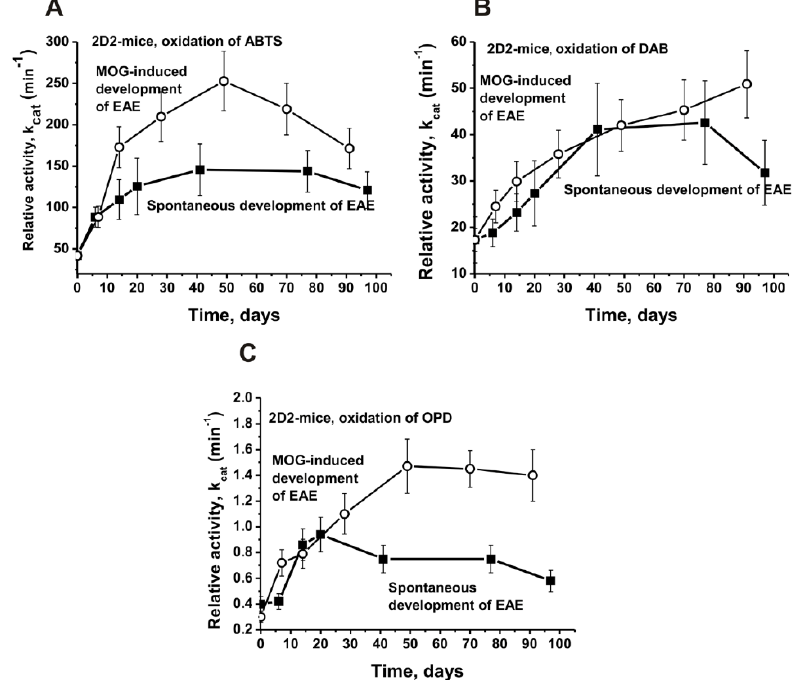
Figure 4. Average changes over time in the relative activity in the oxidation of ABTS ( A ), DAB ( B ), and OPD ( C ) before and after 2D2 mice immunization with MOG. All of the designations are marked in three panels. The mean values of k cat corresponding to 10 mice of each group are presented.